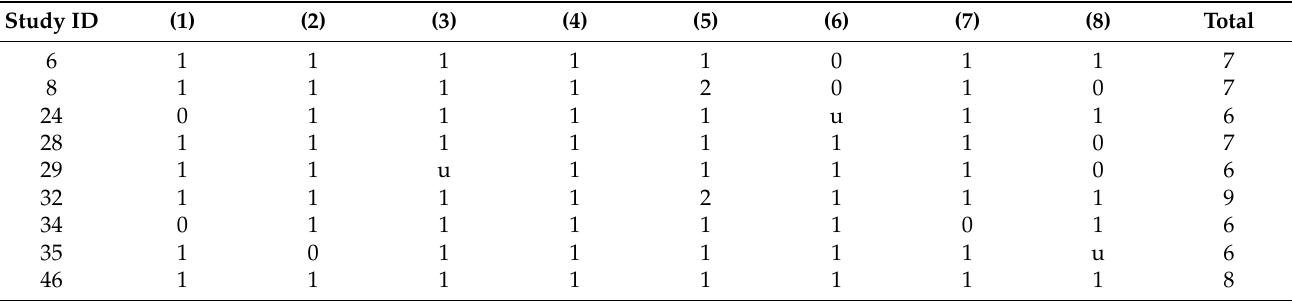
Table A2. Cohort study quality